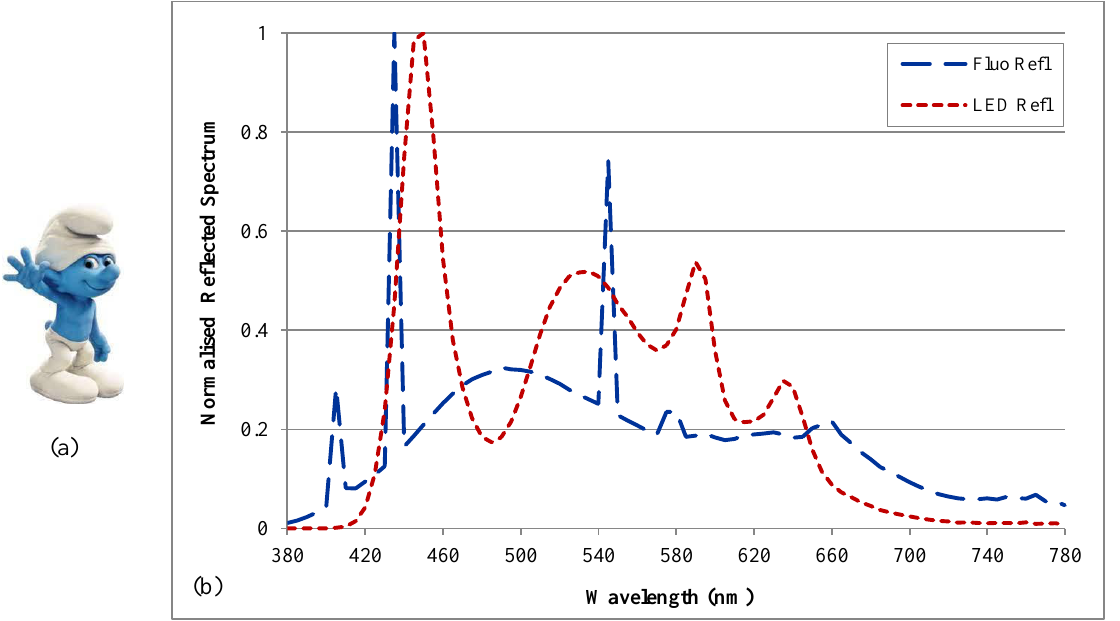
Figure 2. (a) Image of a typical Smurf figurine; (b) Spectra of the reflected light from a Smurf body illuminated, respectively, by each of the two 4000-K sources: Fluorescent: long dash; LED combination: short